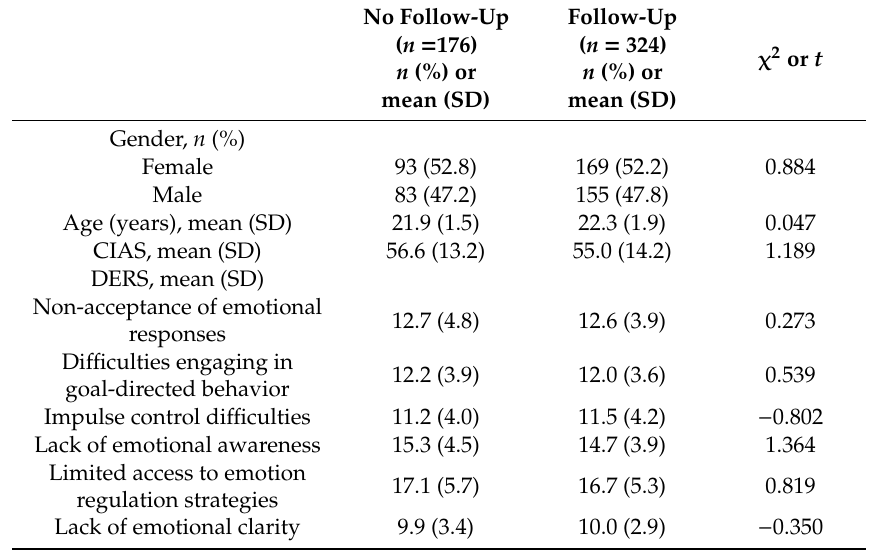
Table 1. Comparisons of demographic data and di ffi culties in emotion regulation between participants who participated in and who did not participate in follow-up assessment.